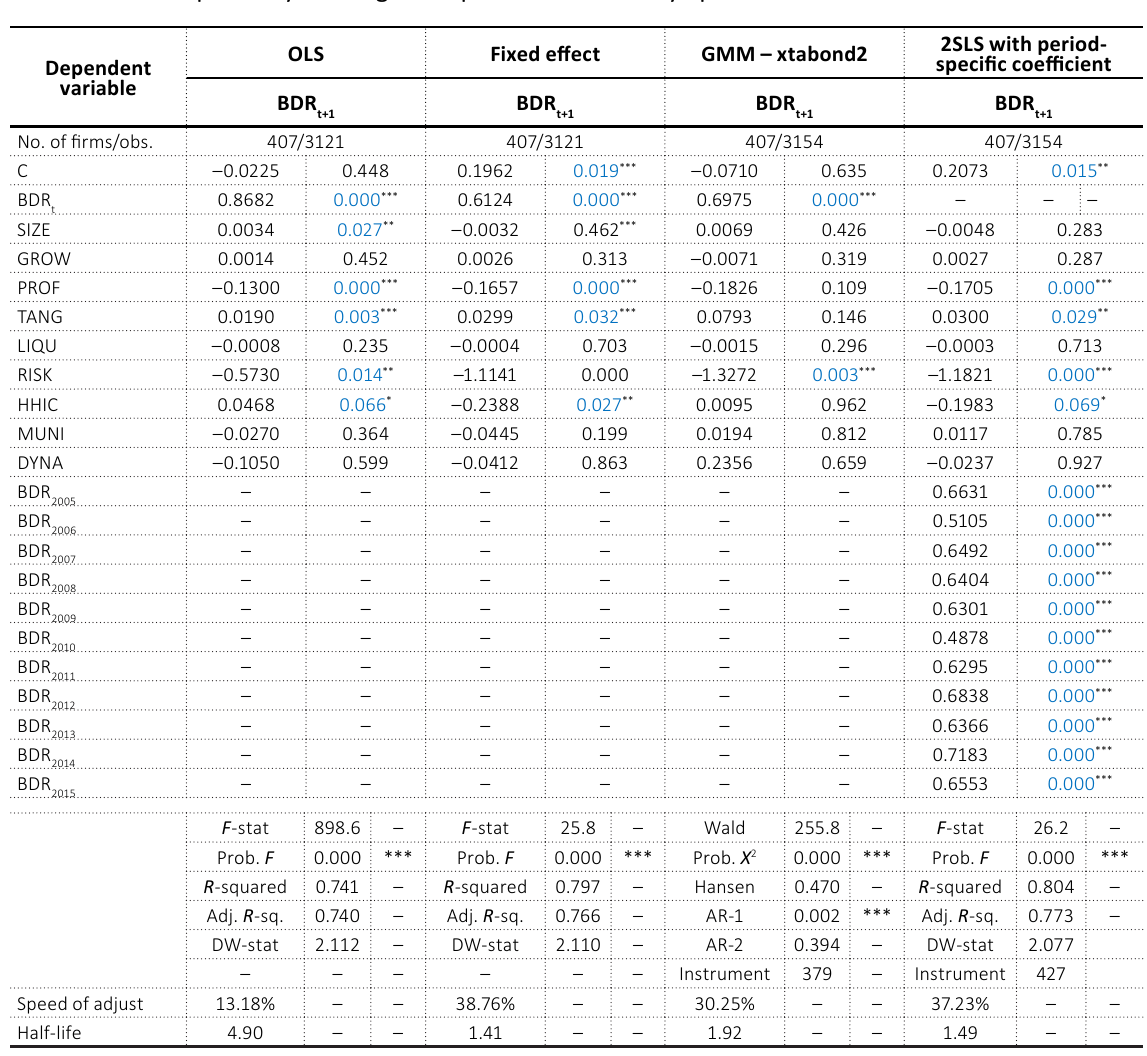
Table 4. Full sample analysis using firm-specific and industry-specific